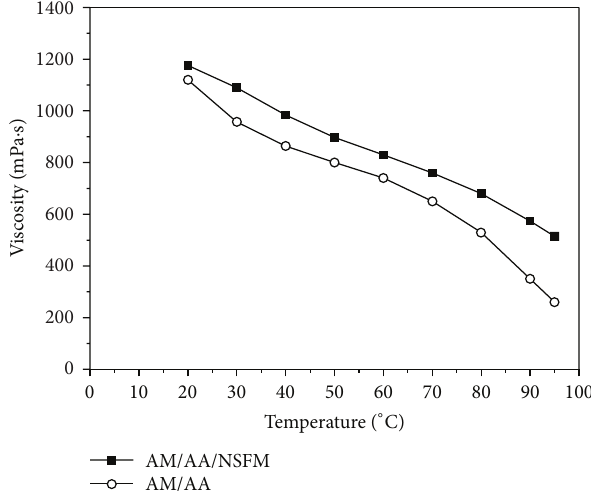
Figure 9: Viscosity versus temperature for AM/AA and AM/AA/ NSFM solution. The viscosity of copolymer solution (0.5wt%) was measured by Brookfiled DV-3 viscometer at 7.34 s −1 using number 62 rotor (rotation speed: